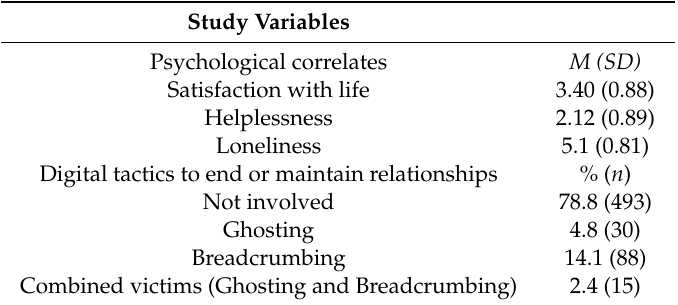
Table 1. Summary statistics of the study variables and frequency distribution of ghosting and breadcrumbing experiences (N =